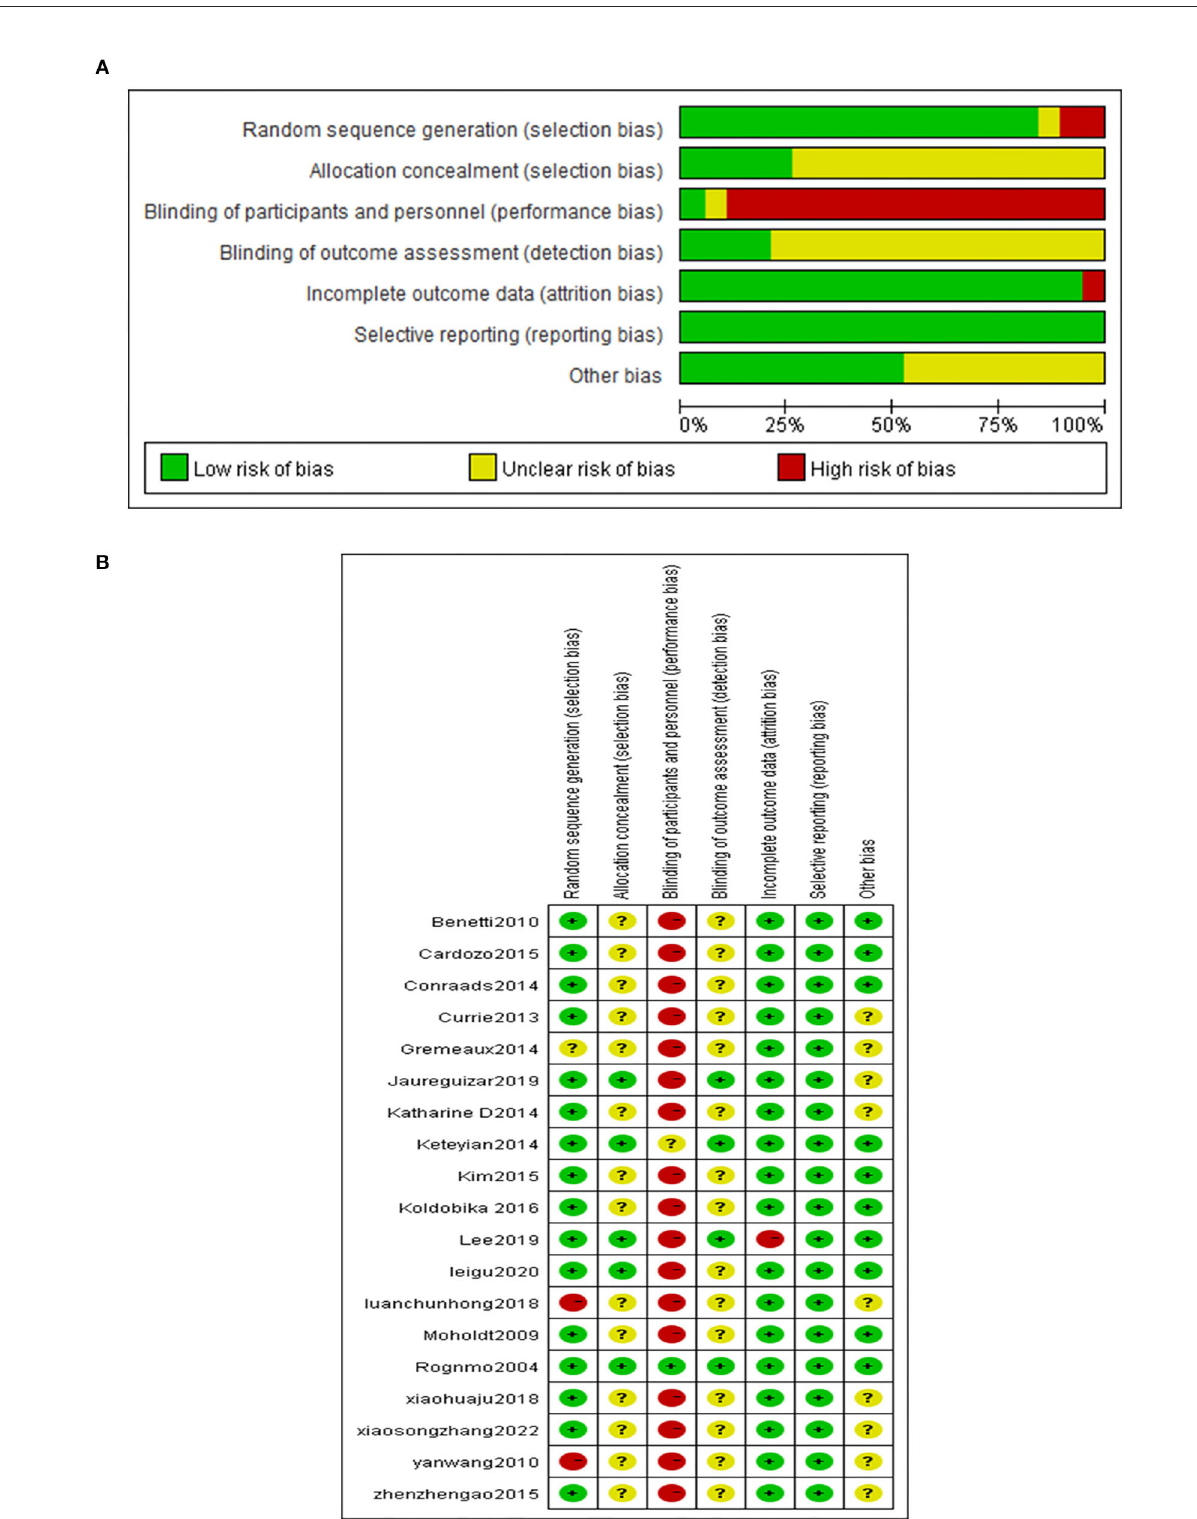
FIGURE2 (A) Overall analysis diagram. (B) Single literature analysis diagram. “ + ” is low risk. “?” is unclear, and “–” is high